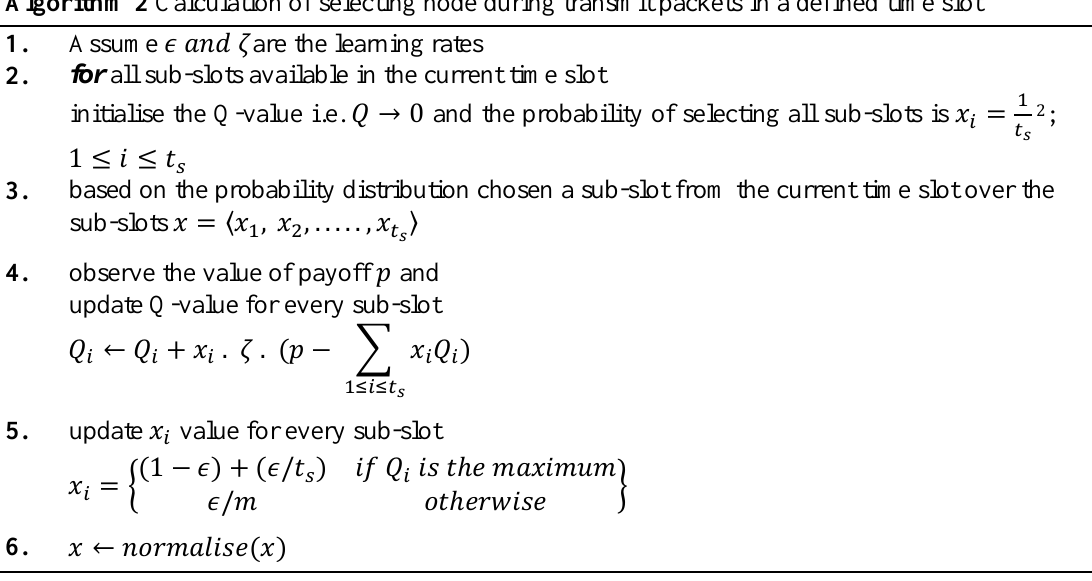
Algorithm 2 Calculation of selecting node during transmit packets in a defined time